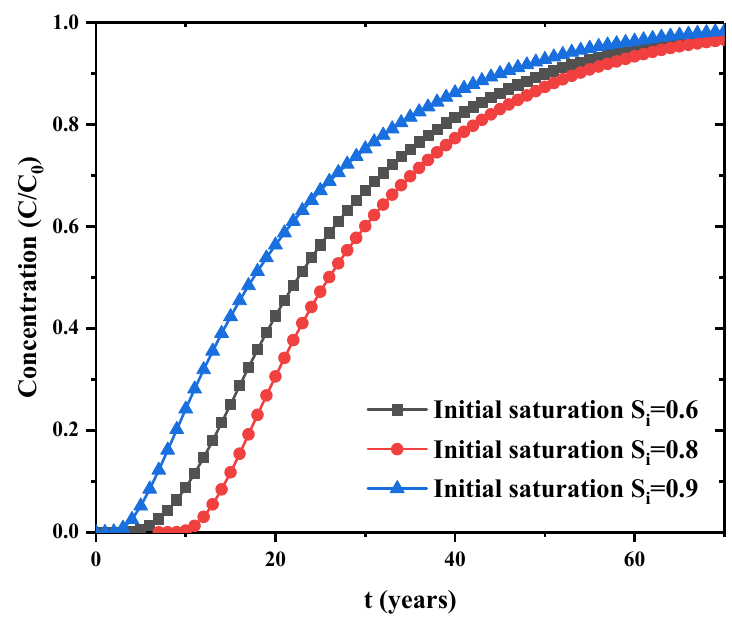
Figure 7. Effect of initial saturation on concentration at bottom point. Figure 7. E ff ect of initial saturation on concentration at bottom